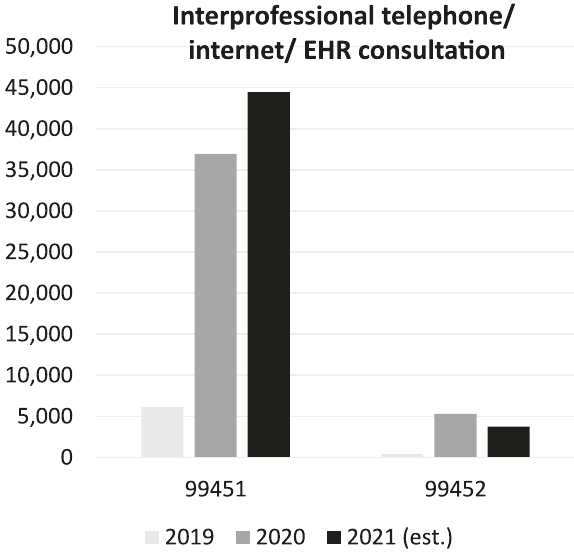
Fig. 2 CPT codes of Interprofessional telephone/ internet/ EHR consultation. The CPT codes are de fi ned as: 99451: Interprofessional telephone/internet/electronic health record assessment and man- agement service provided by a consultative physician, including a written report to the patient ’ s treating/requesting physician or other quali fi ed health care professional, 5 min or more of medical consultative time; 99452: Interprofessional telephone/internet/elec- tronic health record referral service(s) provided by a treating/ requesting physician or other quali fi ed health care professional, 30